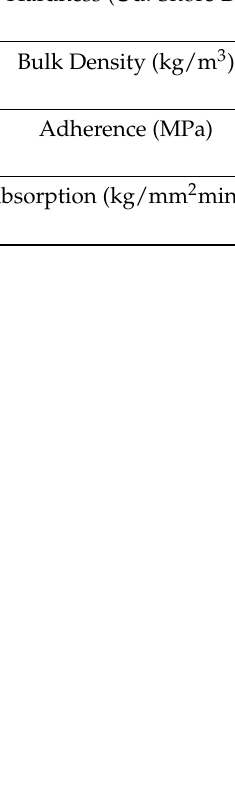
Table 14. Loss of mass in grams and percentage decrease in flexural mechanical strength of specimens subjected to freeze–thaw cycling